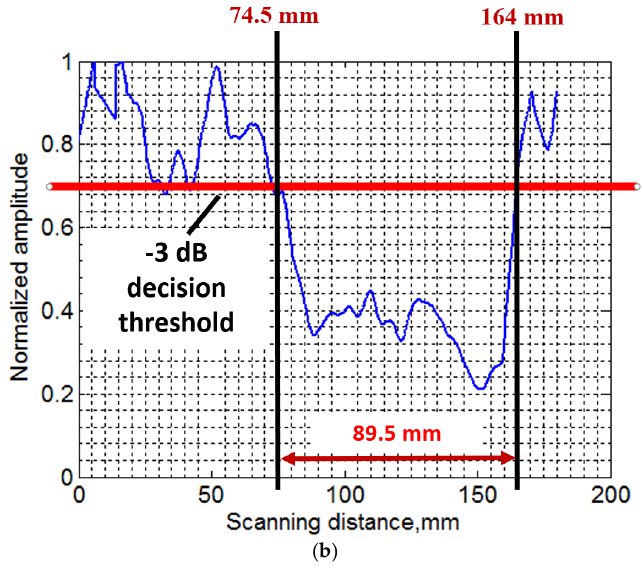
Figure 4. Defect estimation using DWT: wavelet denoised B-scan using db8 mother wavelet ( a ); and application of amplitude detection for estimating the size and location of 81 mm (D81) defect ( b ).